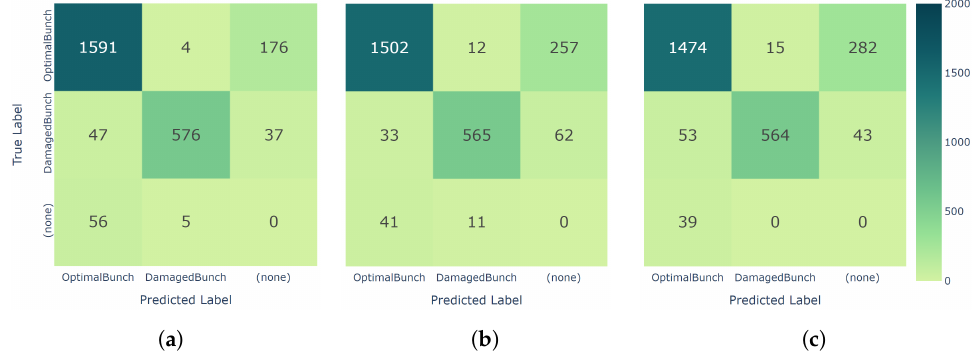
Figure 7. Confusion matrix of each trained model. ( a ) YOLOv5. ( b ) YOLOv7. ( c ) YOLOR.